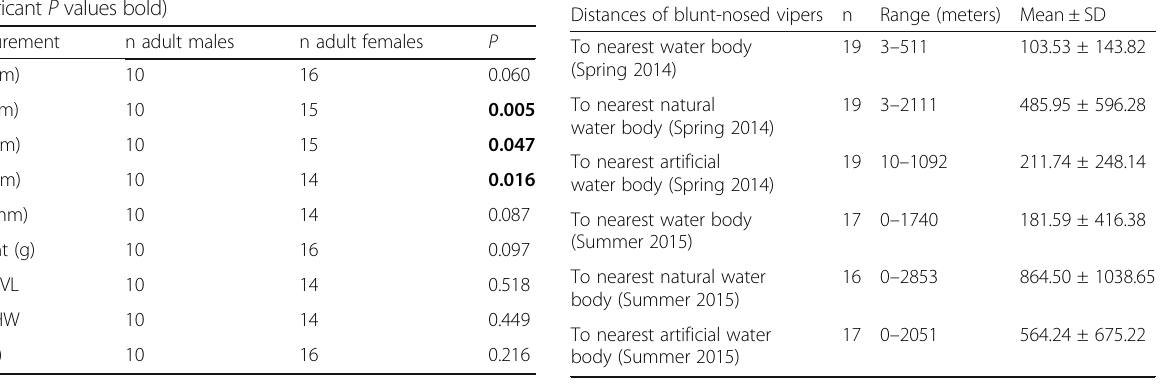
Table 6 Recorded distances of blunt-nosed vipers to the nearest water body (Paphos district,